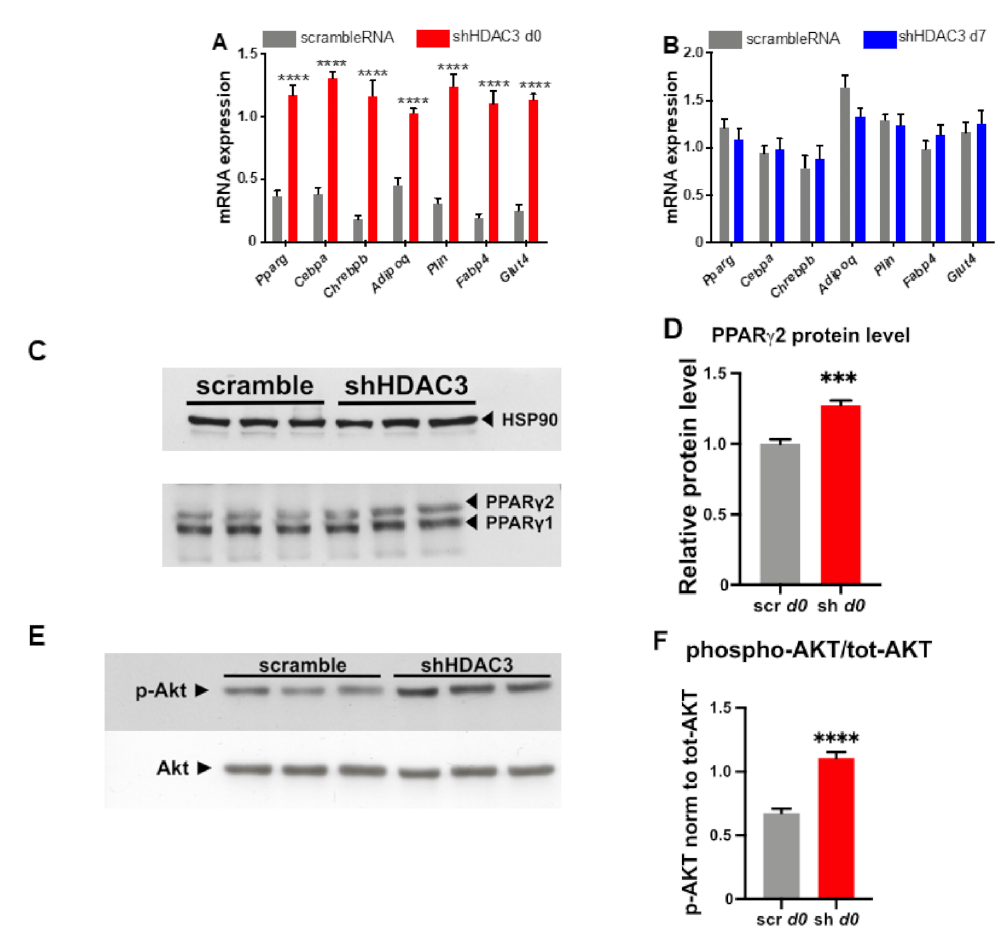
Figure 3. Expression of genes regulating adipocyte differentiation and functionality in C3H/10T1/2 cells infected with scramble/shHDAC3 at day 0 ( A ) or at day 7 ( B ) of differentiation to adipocytes. Cells silenced at day 0 were harvested at day 9 after induction of differentiation, while cells silenced at day 7 were harvested at day 11 after induction of differentiation. Data are presented as mean ± SEM. Statistical analyses were performed with GraphPad PRISM using unpaired Student’s t -test, **** p < 0.0001 ( n ≥ 8 from 3 independent experiments). ( C ) Representative western blot of PPAR γ from C3H/10T1/2 cells infected with scramble/shHDAC3 at d0 of differentiation to adipocytes and ( D ) quantification of the protein bands in panel ( C ); data are presented as mean ± SEM; statistical analysis was performed with GraphPad PRISM using unpaired Student’s t -test, *** p < 0.001 ( n = 6 from 2 independent experiments). ( E ) Representative western blot of C3H/10T1/2 cells infected with scramble/shHDAC3 at d0 of differentiation to adipocytes for detection of phosphorylated Akt (p-Akt) vs. total Akt (Akt); HSP90 was used as a loading control (not shown). ( F ) Quantification of p-Akt/tot-Akt ratio from western blot in panel ( E ); data are presented as mean ± SEM; statistical analysis was performed with GraphPad PRISM using unpaired Student’s t -test, **** p < 0.0001 ( n = 6 from 2 independent